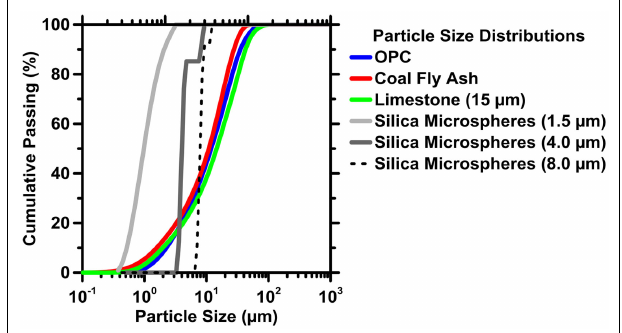
FIGURE 3 | The particle size distributions (PSDs) of cement (OPC), coal fly ash (FA), limestone powders, and silica microspheres . The uncertainty in the measured particle size distribution is 6%, based on variations in the median diameter ( d 50 ) of six replicate measurements. Based on the uncertainty in the d 50 values, the error in the calculated specific surface area is expected to scale with the product of the particle size ( d ) and ∆ d 50 , where ∆ d 50 =